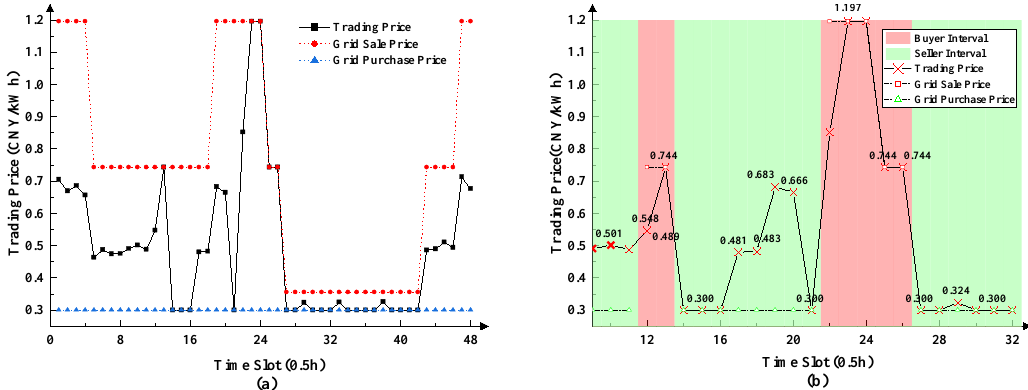
Figure 10. ( a ) Actual trading price of MG 12 in a 24 h trading cycle; ( b ) detailed trading performance of MG 12 between the 9th and 32rd time slot.